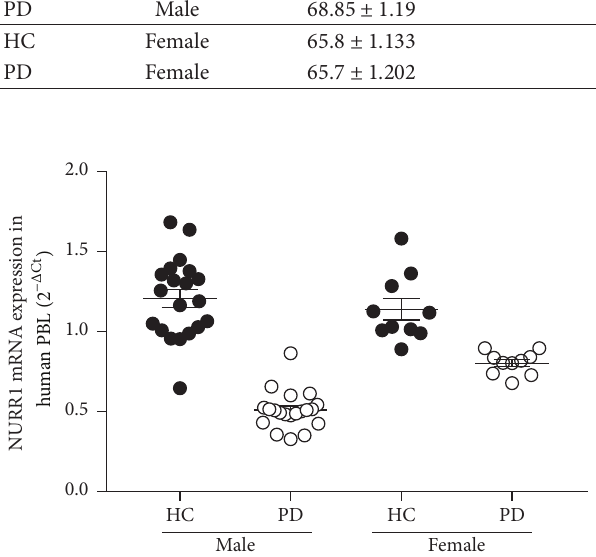
Figure 2: Scatter plot showing FOXA1 mRNA expression on PBL in different study groups. Fluorescent reading from Q-PCR was quantitatively analyzed by determining the difference of Ct between Ct of FOXA 1 and 𝛽 -actin. mRNA expression was determined by using the formation of 2 −Δ Ct . Bars represent mean ± SME measured from duplication assay in blind fashion. 𝑝 < 0.05